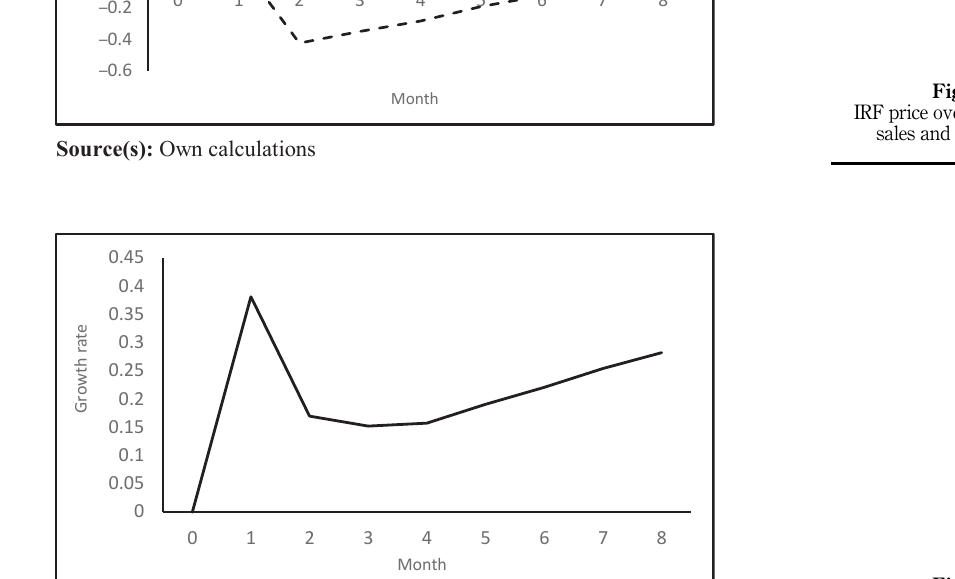
Figure 9. IRF sales over